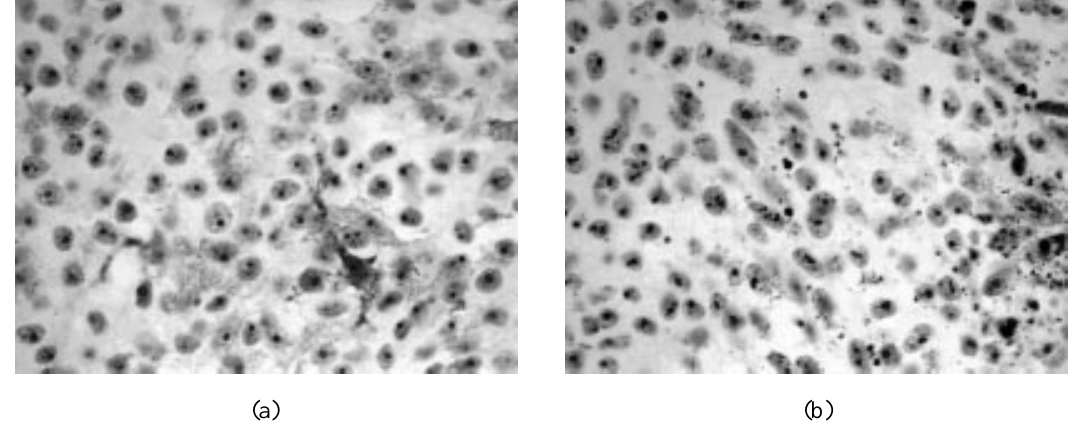
Fig. 1. Choroidal melanoma. (a) AgNORs clustered in regularly shaped collections, (cid:2) 157. (b) Black intranuclear dots in a pigmented area, (cid:2)